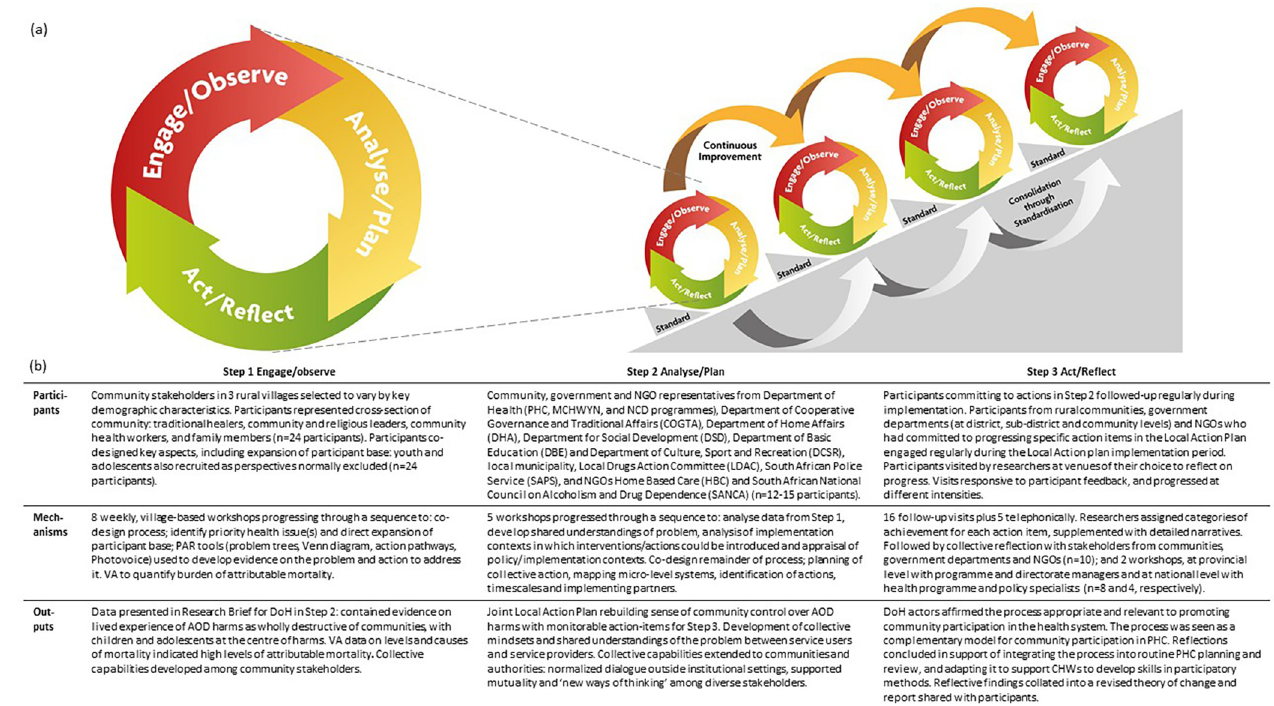
Fig 1. (a) VAPAR schema: adaptive action-learning cycles to coproduce and embed evidence in practice to improve care and outcomes; (b) Action-learning cycle detailing each stage of the process. The schematic diagram in Fig 1 was produced by the research